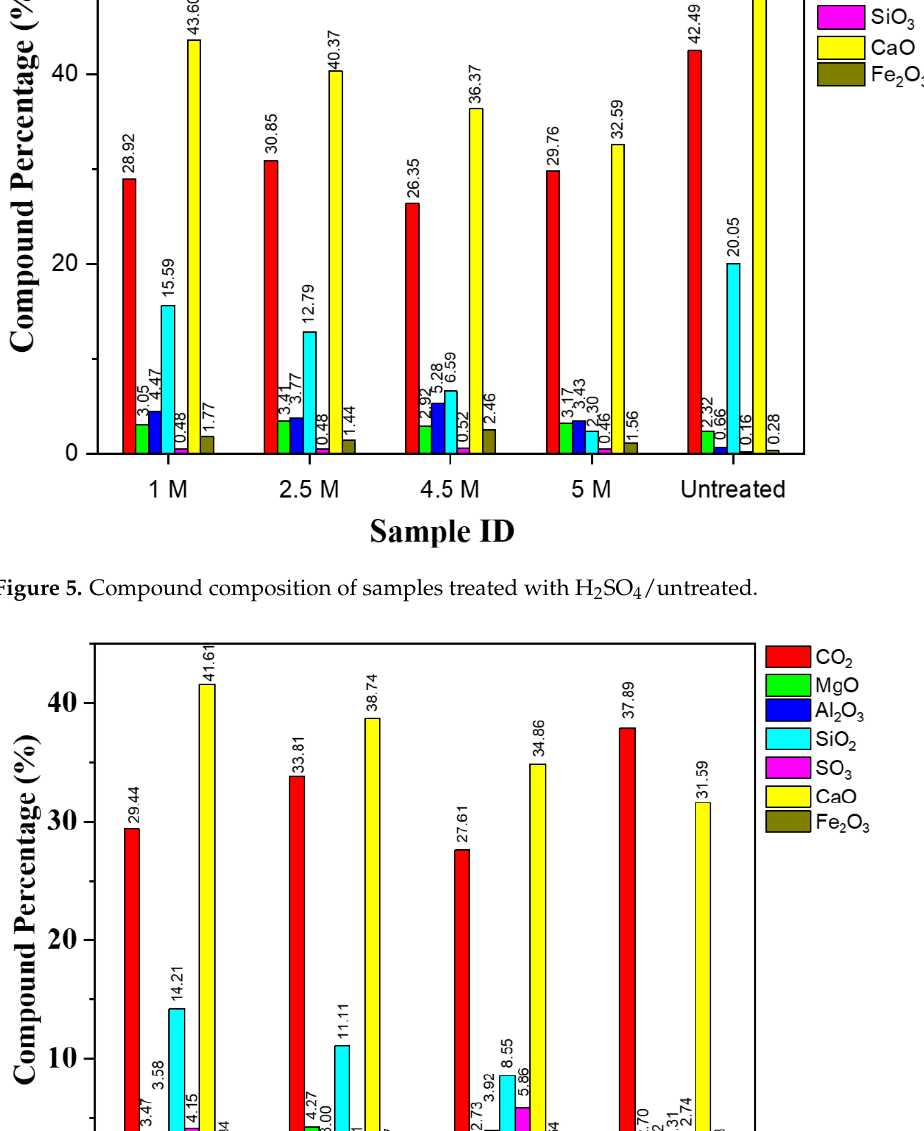
Figure 6. Compound composition of sample treated with